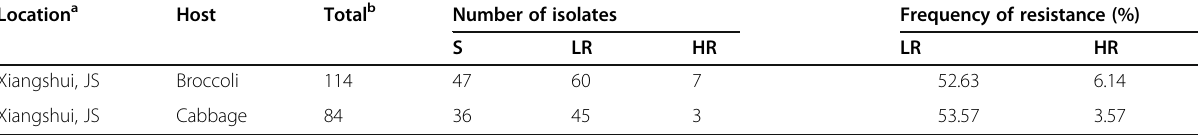
Table 1 Sensitivities of Alternaria alternata isolates to procymidone from Yancheng City, Jiangsu Province, China during 2018 – 2019 Location a